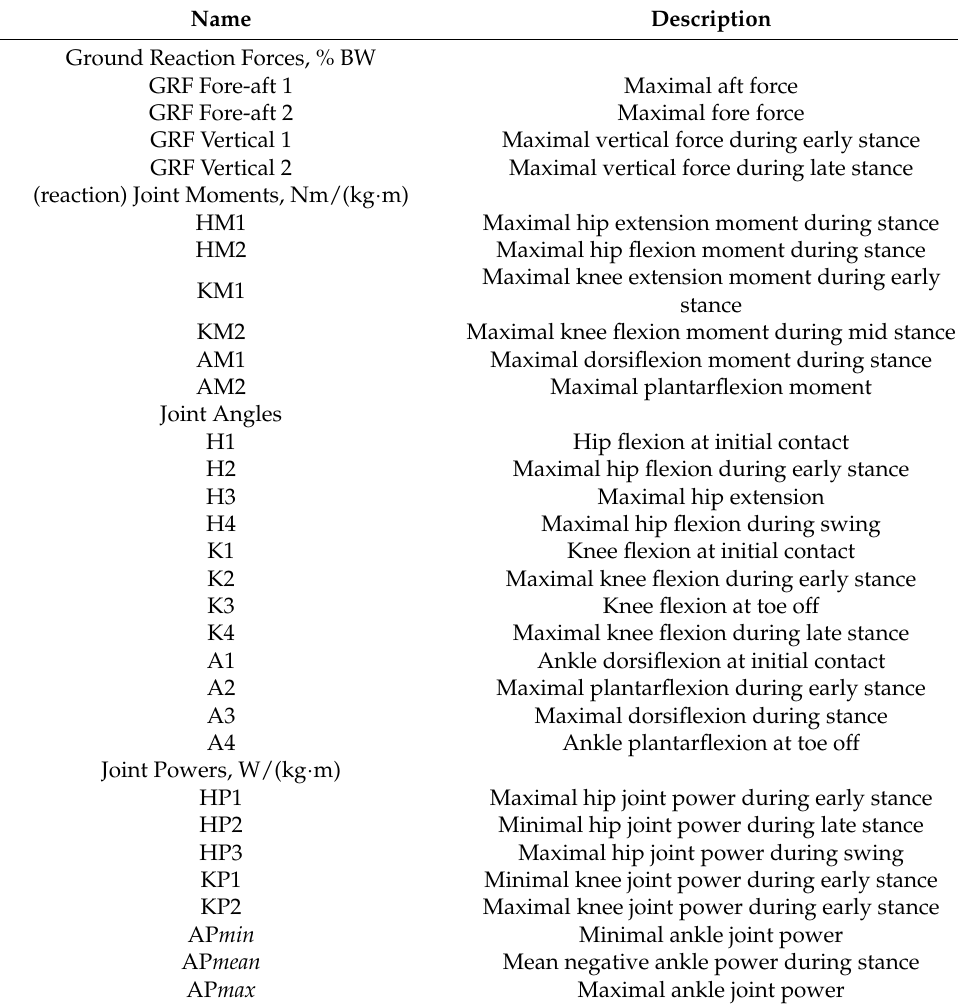
Table 2. Kinematic, kinetic, and energetic gait parameters of